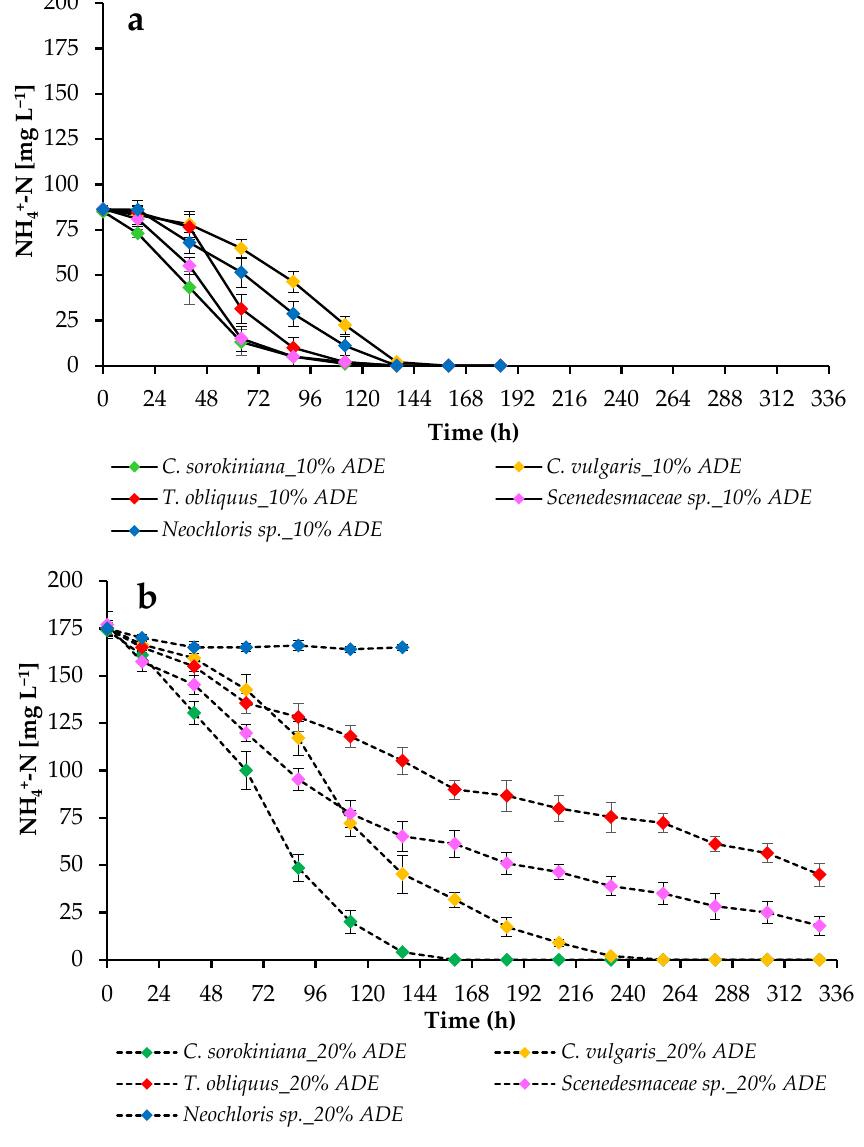
Figure 5. Ammonium nitrogen concentrations in the medium during the growth of microalgae in 10% ADE ( a ) and 20% ADE ( b ).